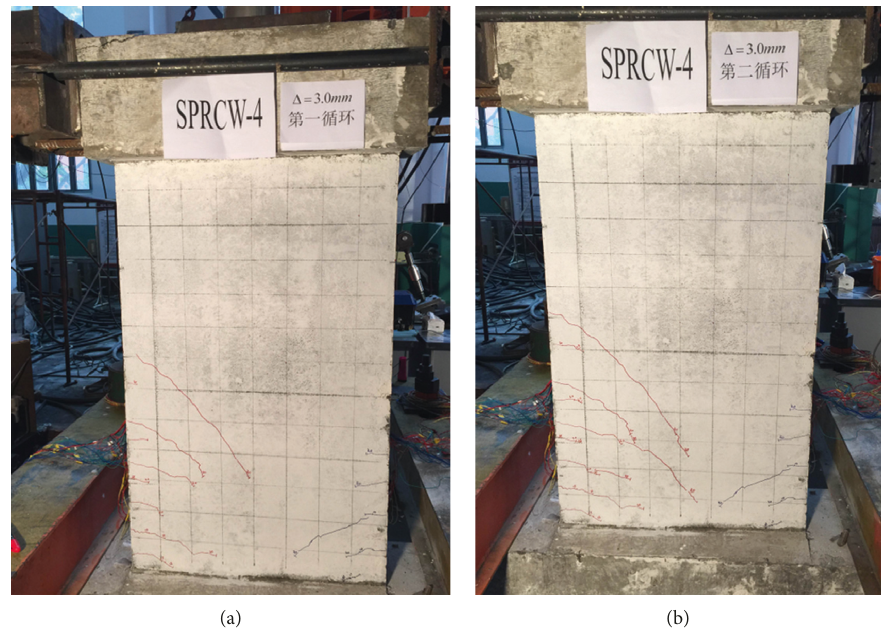
Figure 19: Diagram of cracks in the Δ � 3mm displacement cycle. (a) First cycle. (b) Second